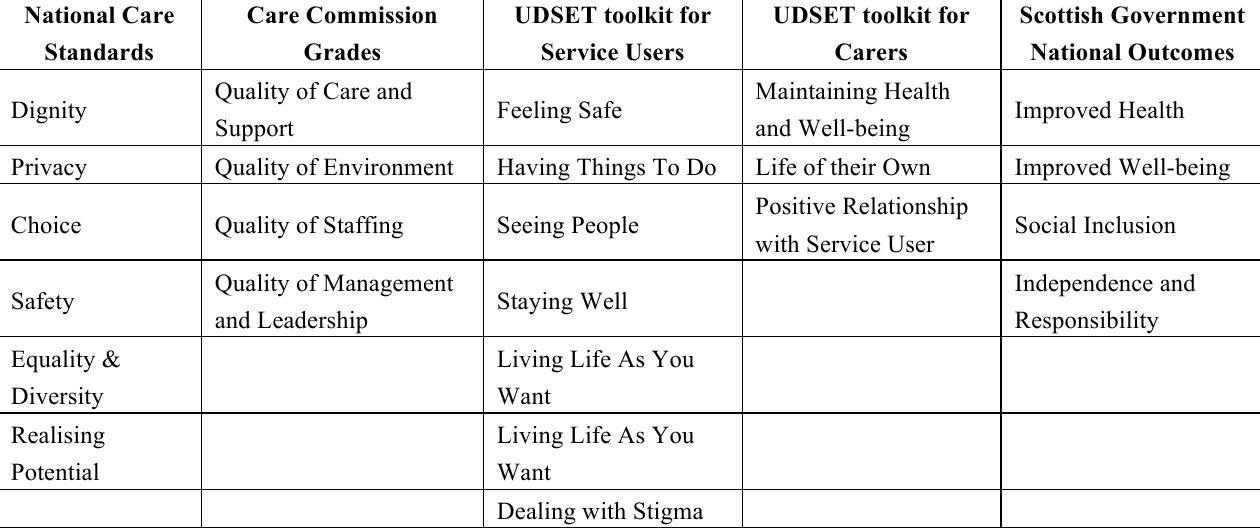
Table 1. Key Performance Indicators related to current health and social care